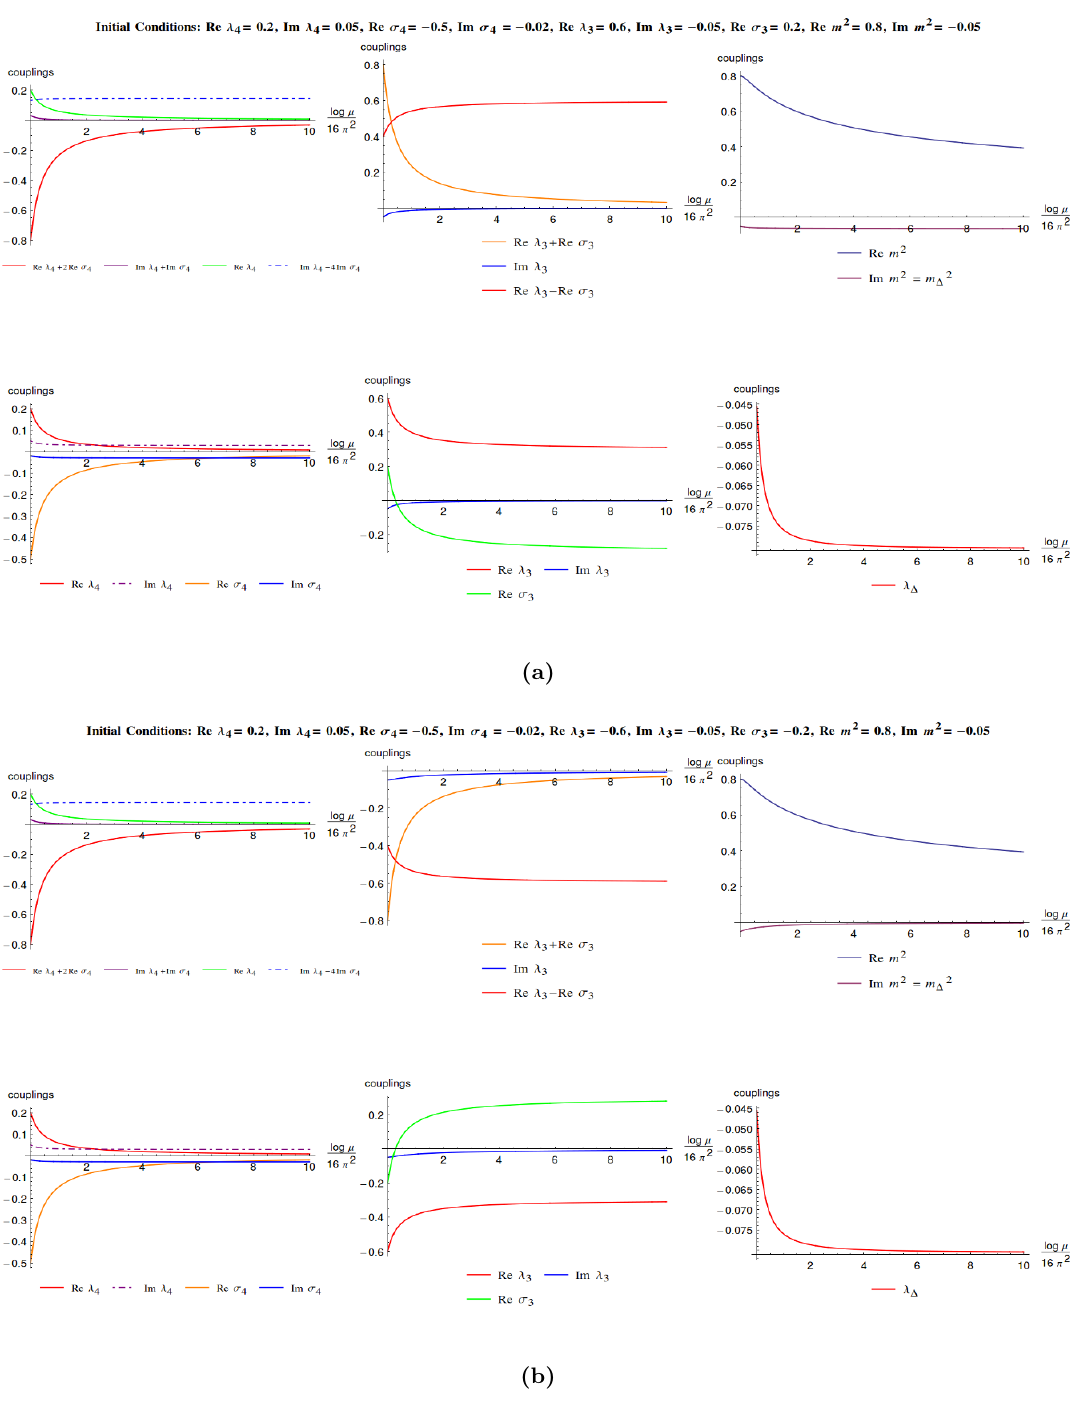
Figure 24. Figures showing the evolution of all the couplings for the case Re (cid:21) 4 + 2Re (cid:27) 4 < 0, Im (cid:21) 4 + Im (cid:27) 4 > 0 and the two sub-cases | Re (cid:21) 3 + Re (cid:27) 3 > 0 ((cid:12)gure a) and Re (cid:21) 3 + Re (cid:27) 3 < 0 ((cid:12)gure b).